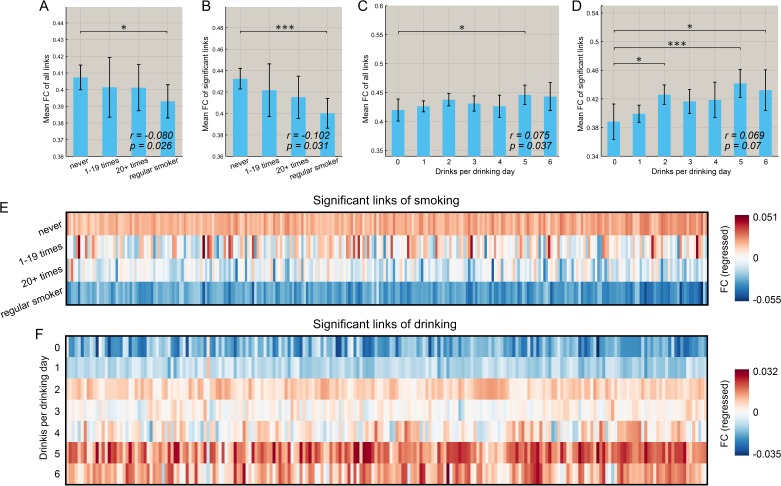
Correlation between the strength of functional connectivity and the amount of substance use behavior.(A) Comparison of the mean strength of all functional connectivities in subgroups that smoked for different numbers of times. The error bars show the standard error of the mean (SEM) in this and other Figures. The mean strength of all functional connectivities in the regular smoking group is significantly lower than in the non-smoking group (p=0.026). The correlation between the strength of FC links and the amount of substance use behavior are shown in the lower right corner (same for other figures). (B) Comparison of the mean strength of significantly different functional connectivities in subgroups who had smoked for different numbers of times. The mean strength of significantly different functional connectivities of the regular smoking group is significantly lower than for the non-smoking group (p=0.031). (C) Comparison of the mean strength of all functional connectivities in subgroups with different amounts of drinking. (D) Comparison of the mean strength of significantly different functional connectivities in subgroups with different amount of drinking. The relation between the strength of the different FCs and the smoking history (E) and the amount of drinking (F). The FCs are those that are significantly different between the substance use and control groups as shown in Figures 2 and 3. * indicates p<0.05, **p<0.005 and ***p<0.0005.